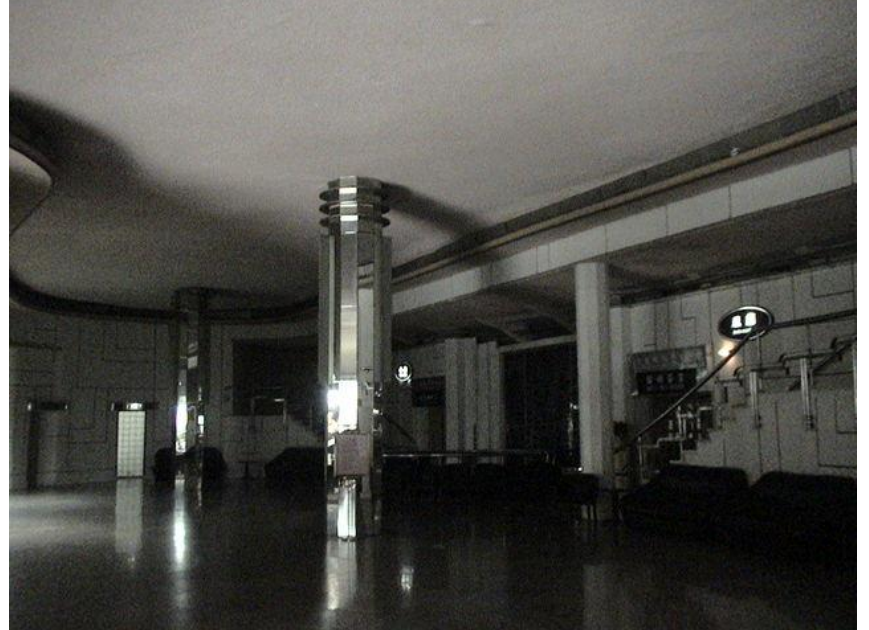
Figure 21. Grand Theatre—the entrance lobby and glittering pillars.